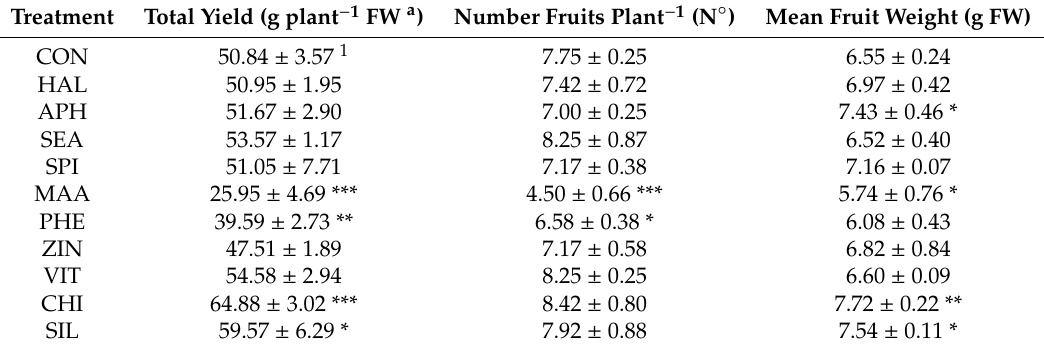
a FW: fresh weight; 1 Means ± SD. Values followed by asterisk indicate significant di ff erences between a single treatment group and control group, according to Dunnett’s test ( n = 4). *** p < 0.001; ** p < 0.01; * p < 0.05; no asterisk indicates absence of any significant di ff